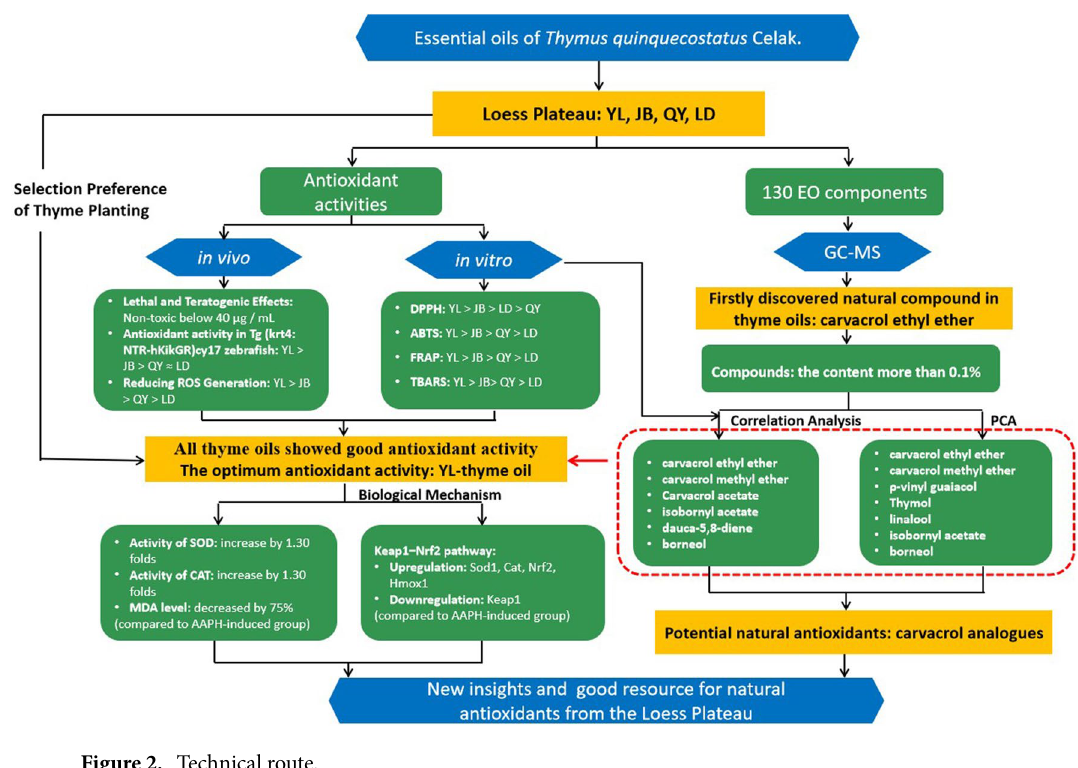
Figure 2. Technical